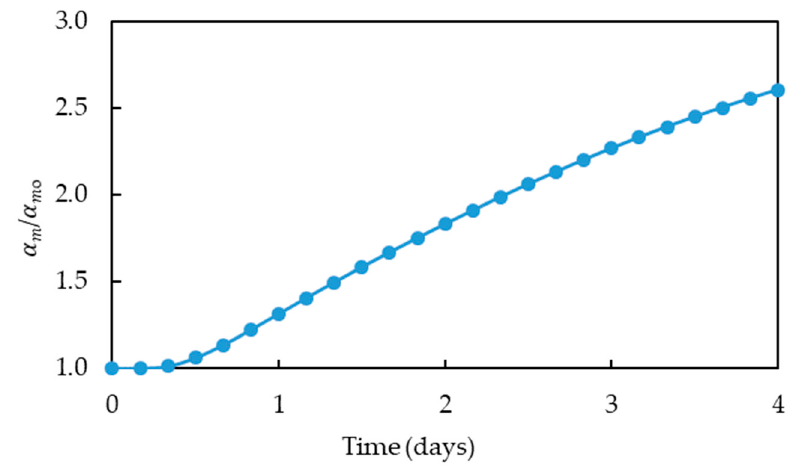
Figure 6. Ratio of carbon dioxide production after applying heat with respect to the reference value of carbon production at initial temperature ( α m / α mo ) at a single point located in the middle of the domain.